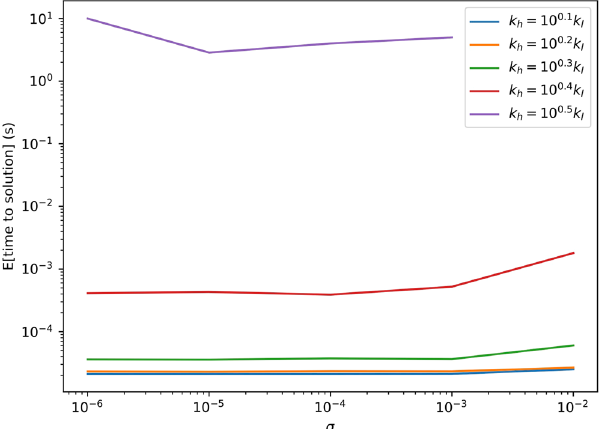
Figure 4. The expected annealing time required to obtain the correct permeabilities on the 1D inverse problems with 972 permeabilities using the D-Wave 2X from the observed hydraulic heads is shown as a function of the noise level ( x -axis) and permeability contrast (the different colored